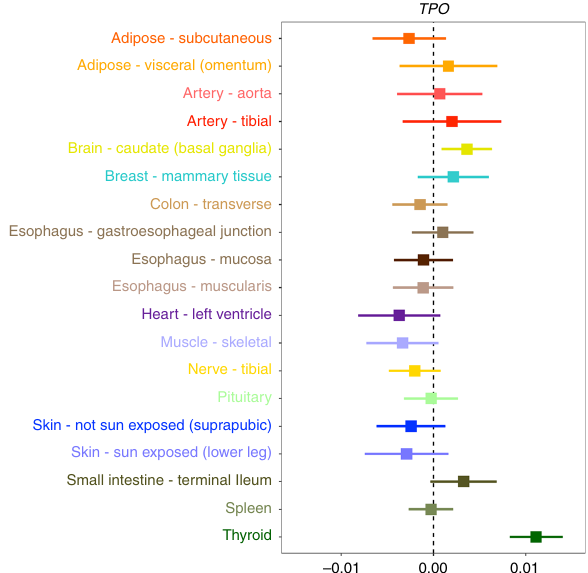
Fig. 4 Forest plot illustrating the tissue-dependent association for TPO expression and thyroid disease. The horizontal line in this plot indicates the null of beta = 0 and the error bars correspond to 95% con fi dence intervals. There was only a valid eQTL for 19 of the 48 tissues in GTEx for TPO